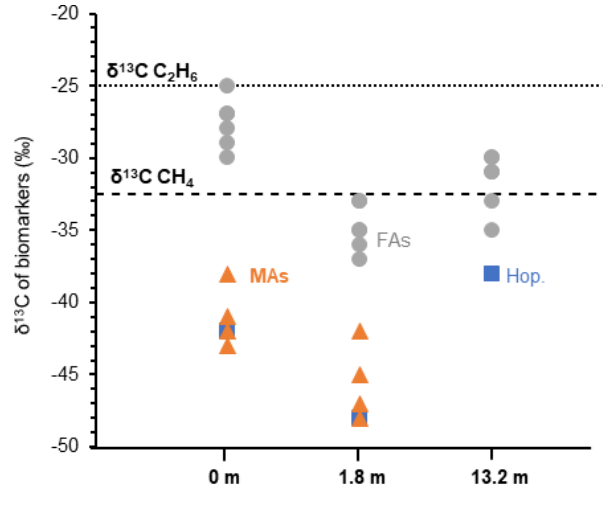
Figure 5. The stable carbon isotopic composition ( δ 13 C) of biomarkers in the Censo soils at increasing distance from the main gas seepage. Biomarkers shown are fatty acids (FAs: grey circle), mycocerosic acids (MAs: orange triangle) and the C 32 hopanoic acid (Hop.: blue square). Data points represent the mean average of two analysis. The δ 13 C values of the released methane (CH 4 ∼ − 32 . 5‰) and ethane (C = − 25‰) are indicated by dashed 2 H 6 lines in the